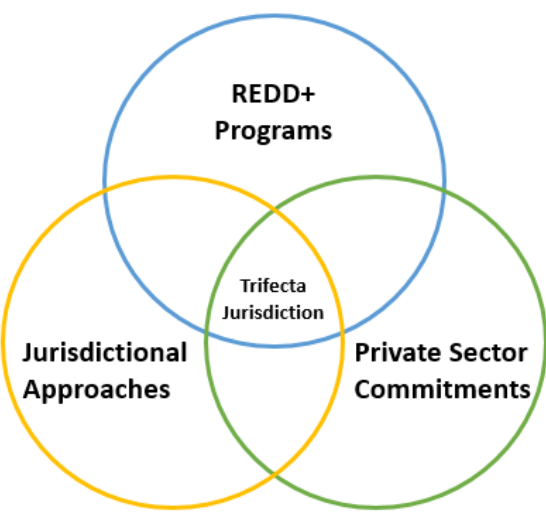
Figure 1. Elements of a trifecta jurisdiction.